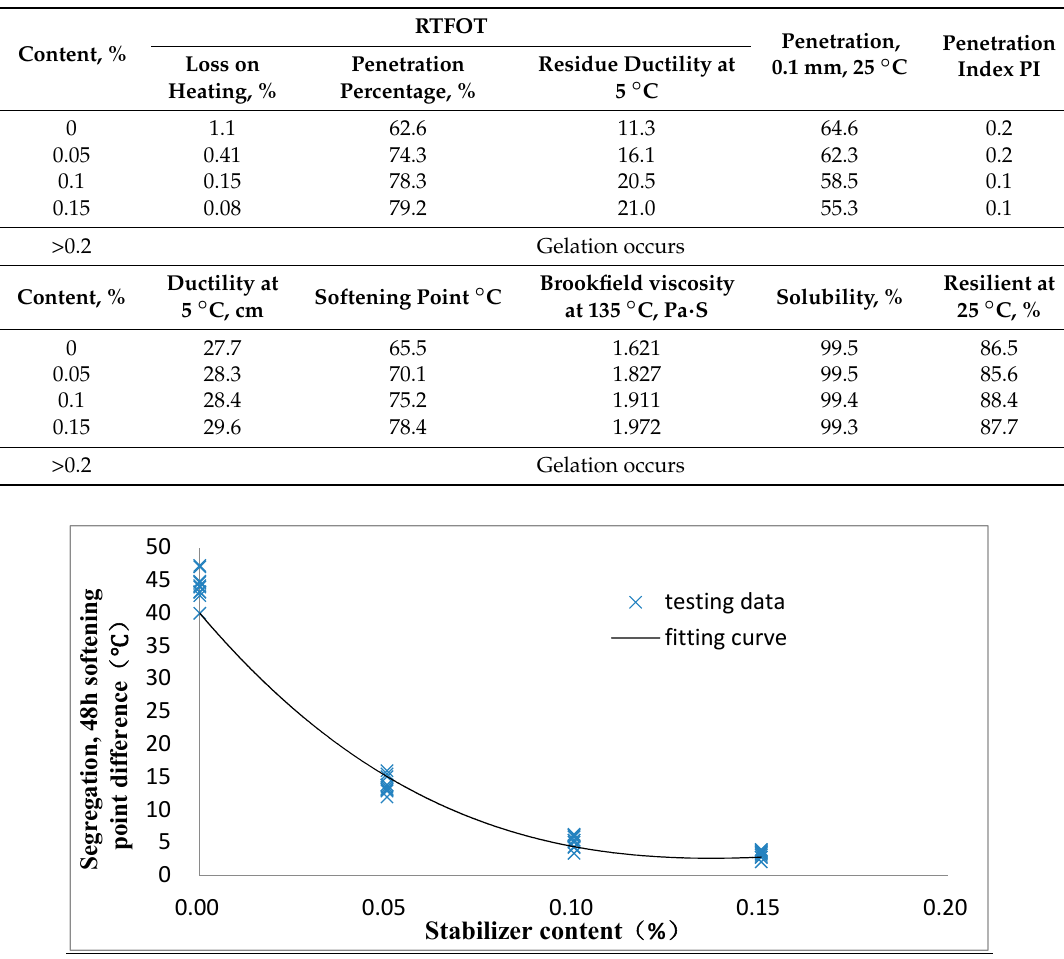
Table 6. The composition with kaolin or carbon-white stabilizer.